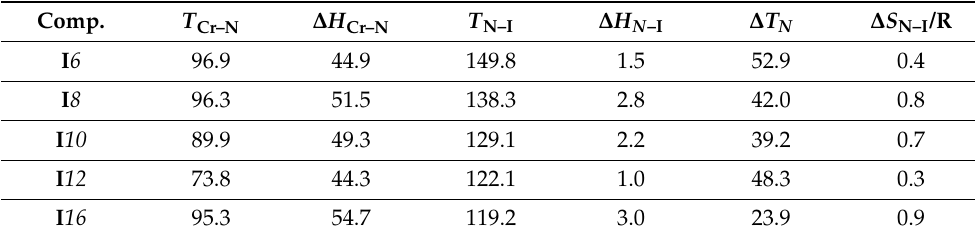
Table 1. Mesophase transition temperatures ( ◦ C), enthalpy ∆ H , kJ/mole, and normalized entropy of transition ∆ S / R for compounds I n .